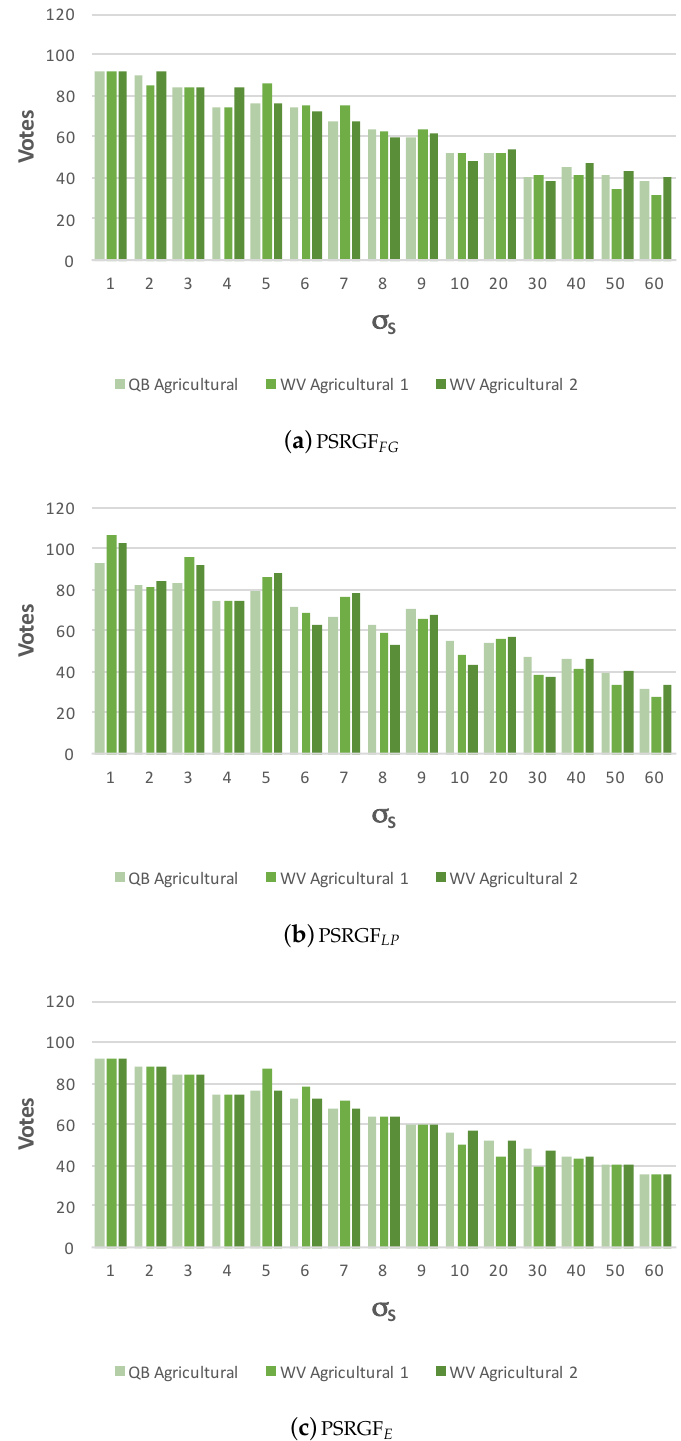
Figure 6. Comparison of the quality indexes set of pansharpened images obtained by: ( a ) PSRGF FG ; ( b ) PSRGF LP and ( c ) PSRGF E for different values of σ s , using Borda count